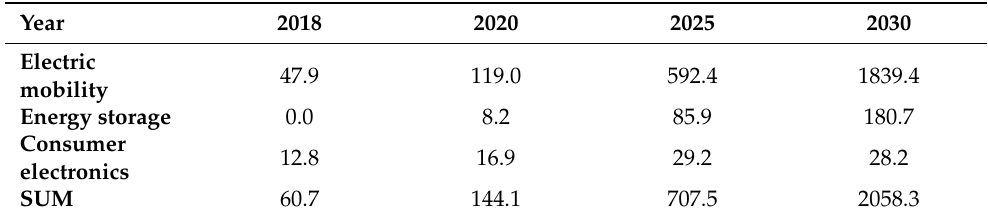
Table A2. Global LIB battery demand by application in GWh for the year 2030, WEF base case [14], including forecasts by Zhao et al. [15].